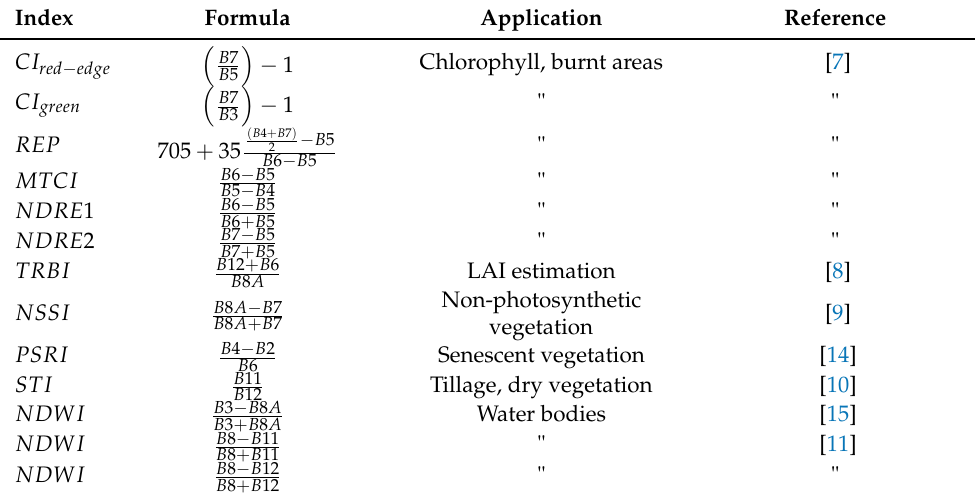
Table 2. Spectral indices leveraging Sentinel-2 spectral bands for applications related to vegetation and water